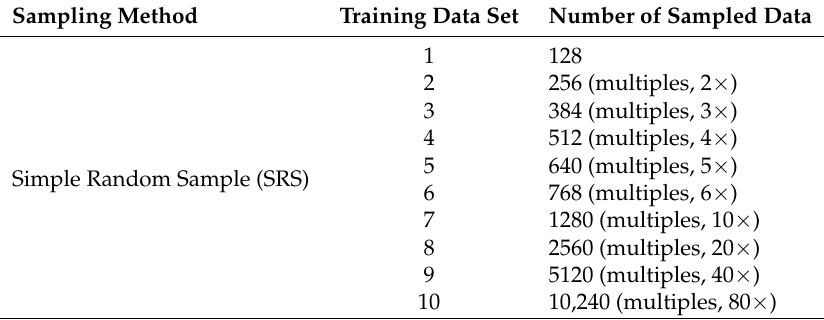
Table 3. Raw data and nine data sets augmented by Simple Random